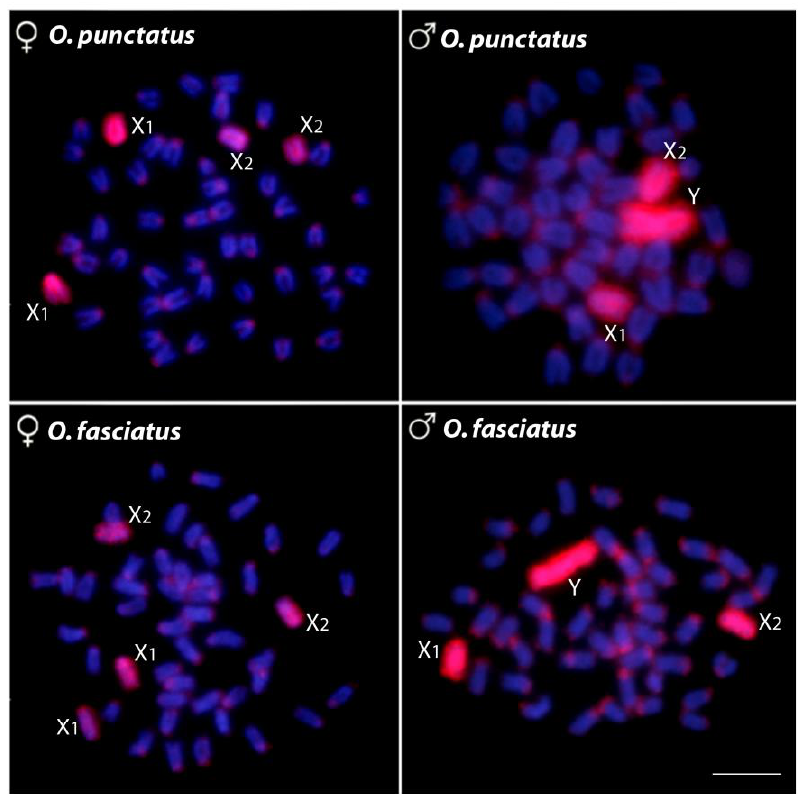
Figure 5. Chromosome painting with the OFAS-Y probe (red) applied onto male and female metaphase chromosomes of O . fasciatus and O . punctatus . Chromosomes were counterstained with DAPI (blue). Note that the OFAS-Y probe completely painted the Y-chromosomes, as well as the X 1 and X 2 chromosomes in both species. Scale bar = 5 μm.